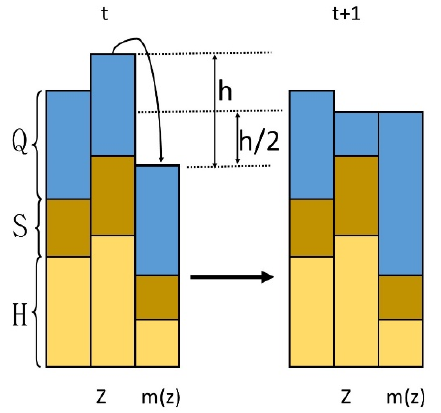
Figure 2. Allocation on cells.